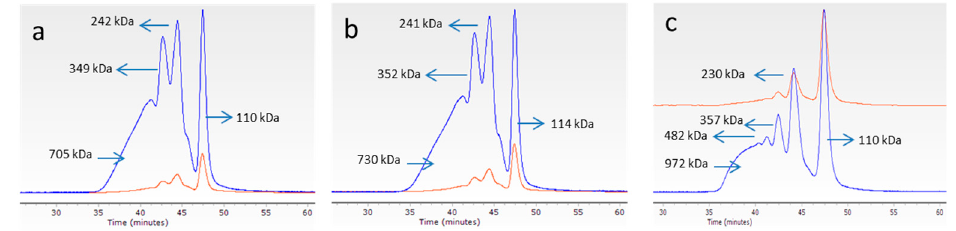
Figure 6. Weight average molecular weights ( M w ) of M. merluccius collagen fractions ( a ) F1, ( b ) F2, and ( c ) F3. Blue line: 90 ◦ light-scattering signal (LS); red line: refractive index signal (RI).